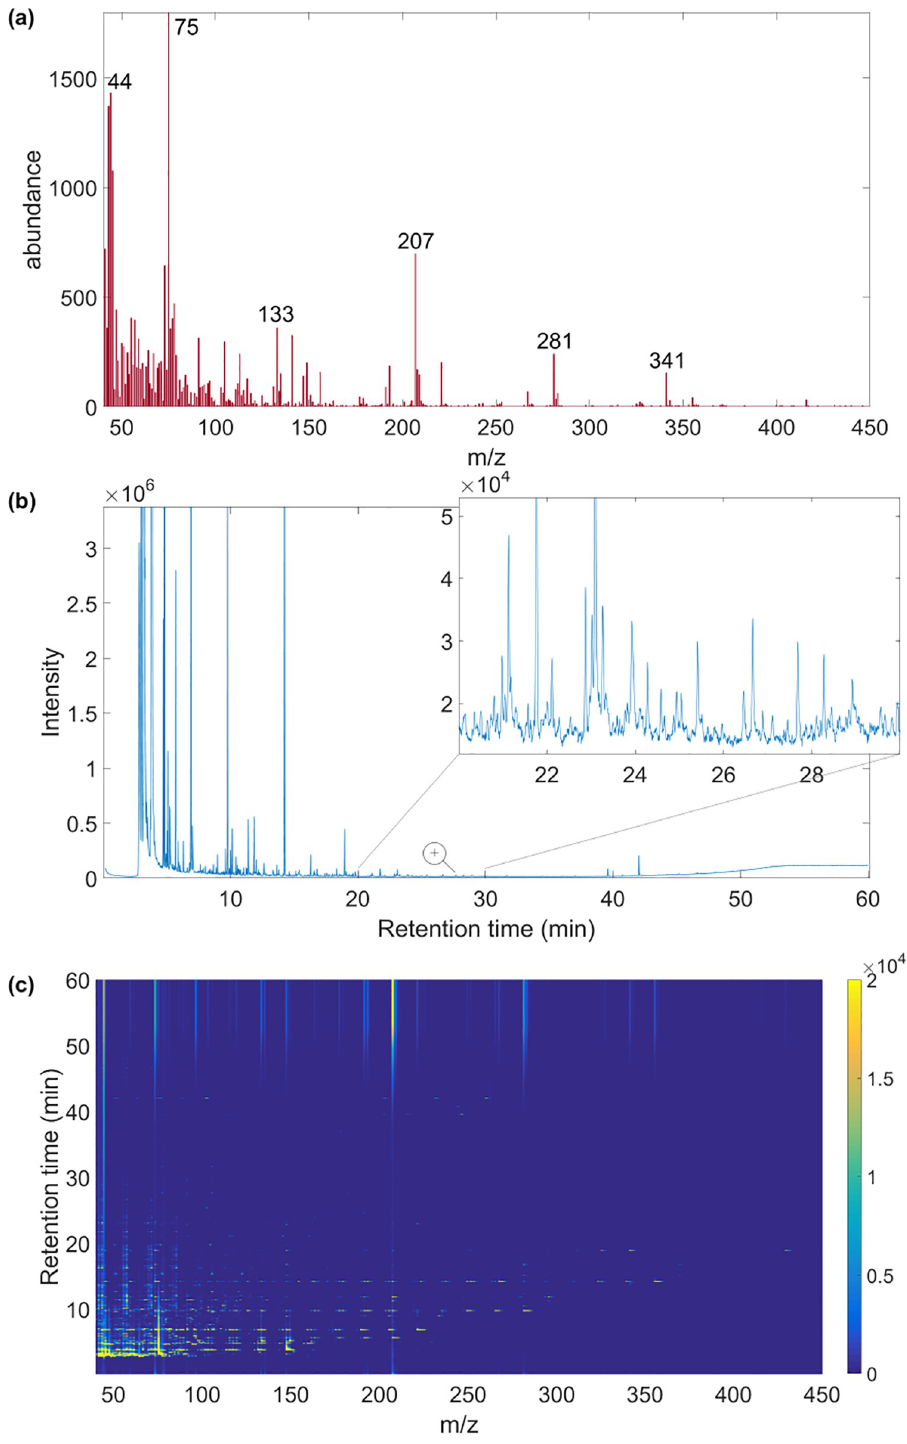
Fig 1. GC-MS breath data. (a) A full mass spectrum corresponds to each retention time ( RT ) point on the chromatogram. (b) The total ion current (TIC) chromatogram plots along the RT dimension the cumulative abundance of ions (intensity). Each peak generally represents one specific VOC, although superposition of peaks also occurs [1]. (c) GC-MS abundance matrix presented as a heat map, with the x-axis being the mass-to-charge ratio ( m/z ) and the y-axis the retention